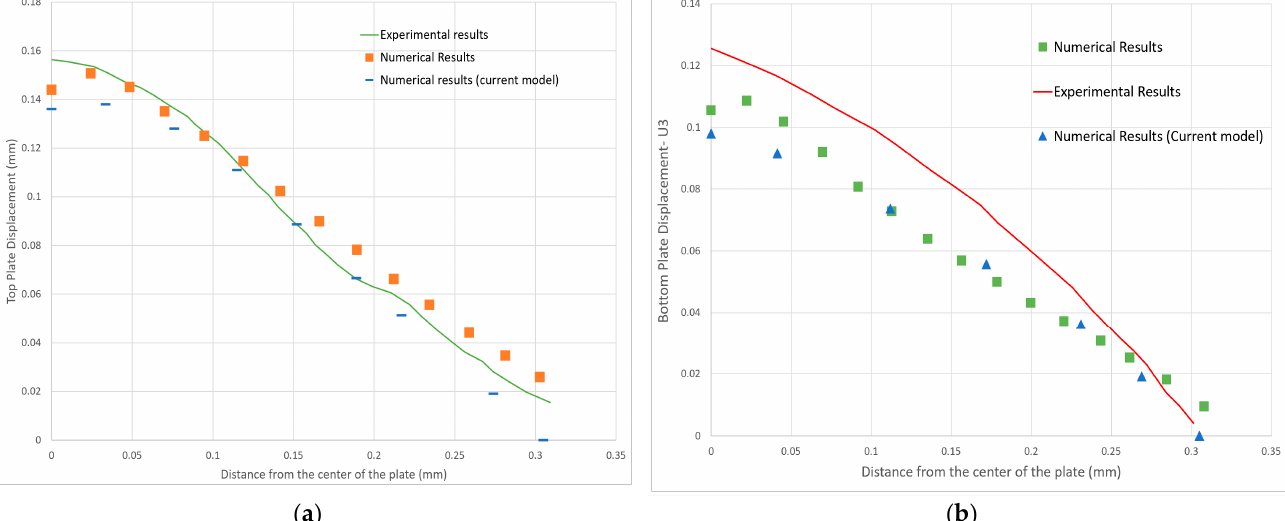
Figure 6. ( a ) Boundary conditions ( b ) core and top plate tie constraint.